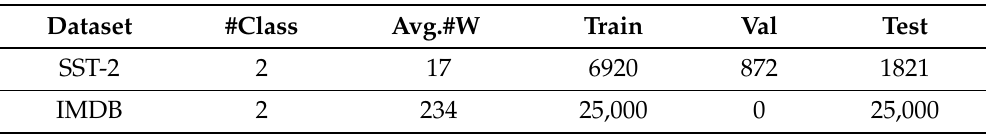
Table 1. Details of datasets. “#Class” means the number of classifications. “Avg. #W” signifies the average sentence length (number of words). “Train”, “Val” and “Test” denote the instance numbers of the training, validation and test sets,